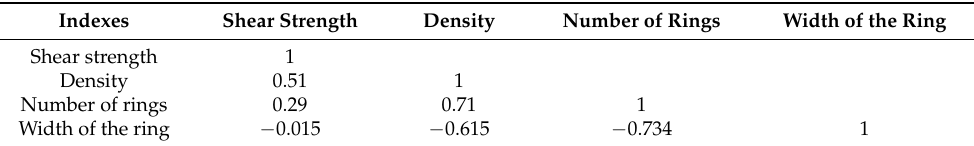
Table 1. Correlation coefficient r between shear strength, density, the number of tree rings, and the width of the shear